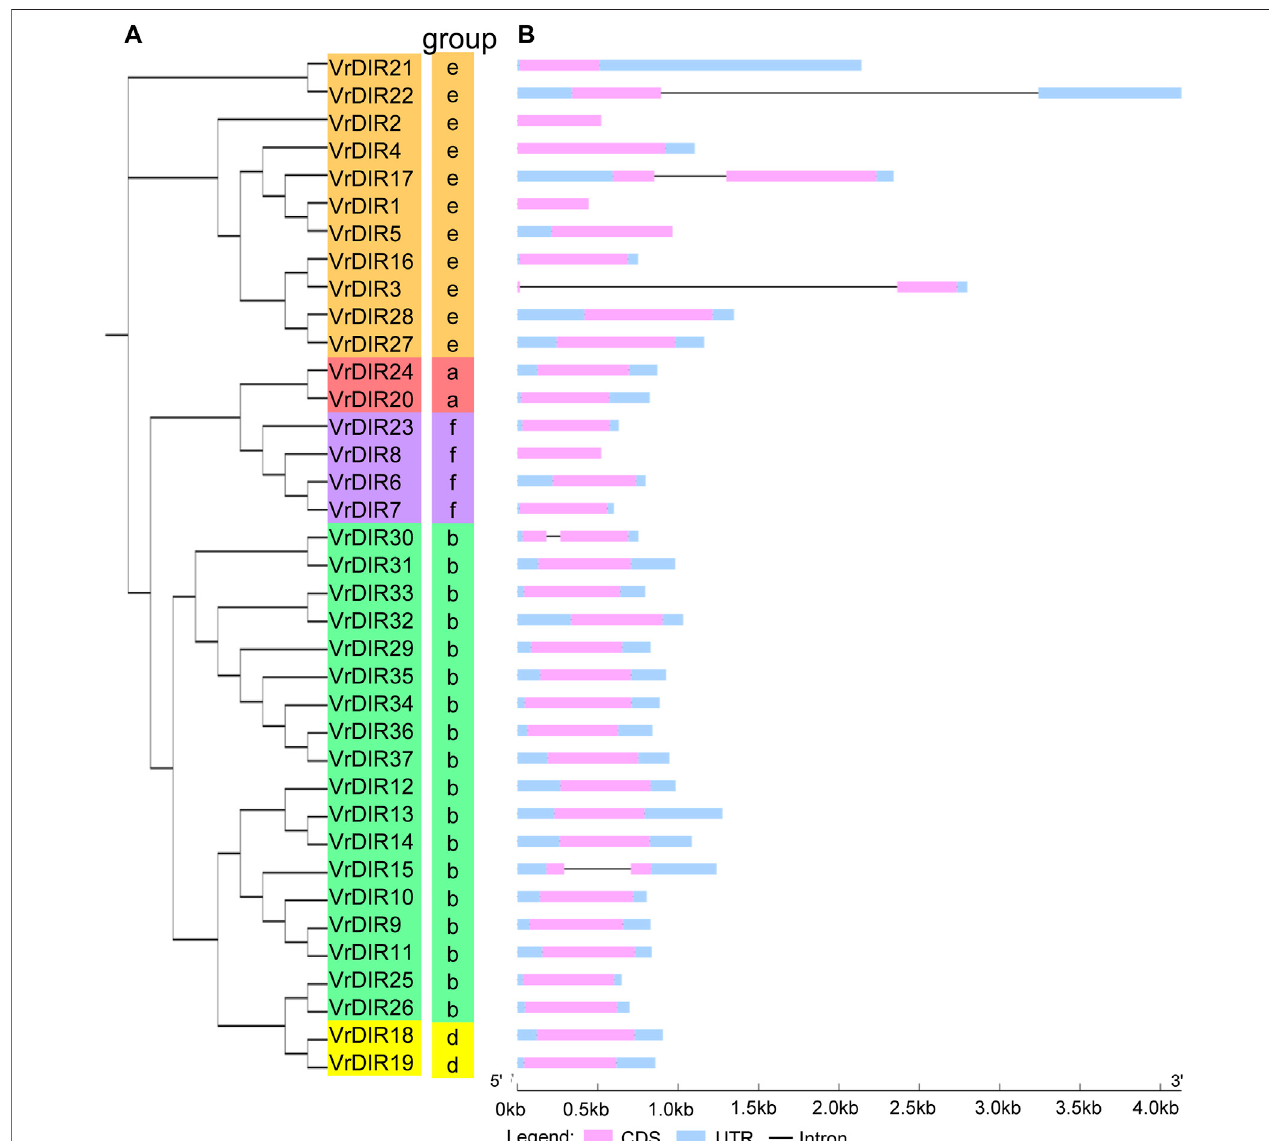
FIGURE2| PhylogeneticandgenestructureanalysesofVrDIRgenes. (A) PhylogeneticanalysisofVrDIRproteins.ThephylogenetictreewasconstructedinMEGA 7.0usingtheneighbor-joiningmethod. (B) Exon-intronorganizationof VrDIR genes.Thelightblue,pink,andblackboxesindicateUTRs,exons,andintrons,respectively. The genomic lengths of VrDIR genes are